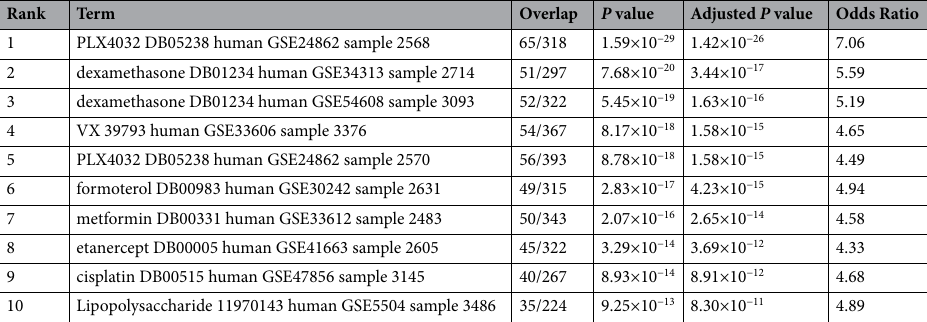
Table 6. Drug perturbations from GEO down for A549 by DESeq2.